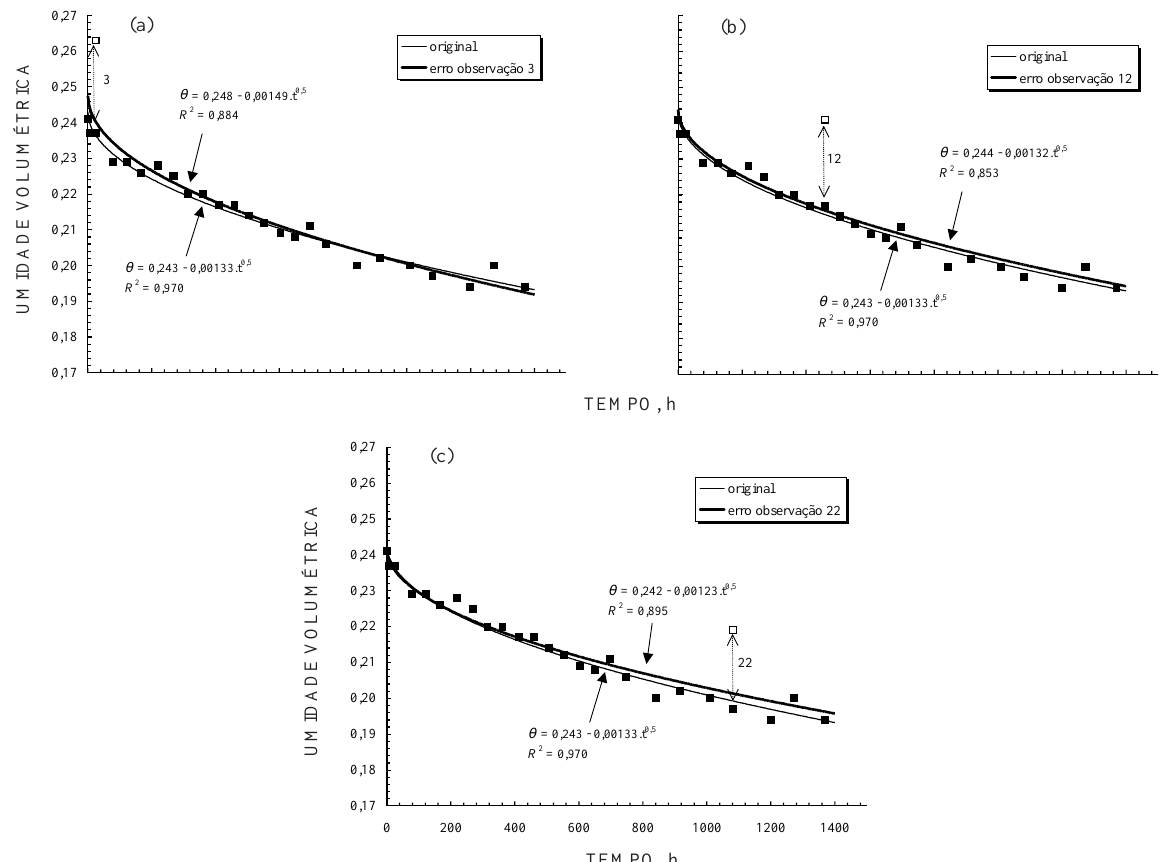
Figura 10. Efeito de um erro de +10 % em uma das leituras do TDR no local P (0,30-0,45 m) no ajuste de equação aos valores da umidade em função do tempo: (a) erro na observação com número de ordem 3; (b) erro na observação com número de ordem 12; (c) erro na observação com número de ordem